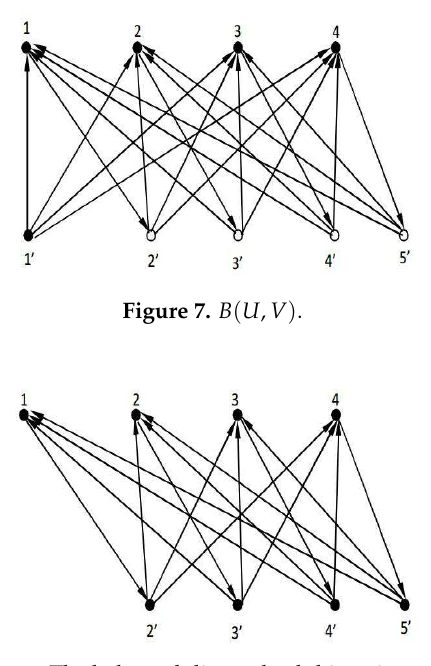
Figure 8. The balanced directed sub-bipartite